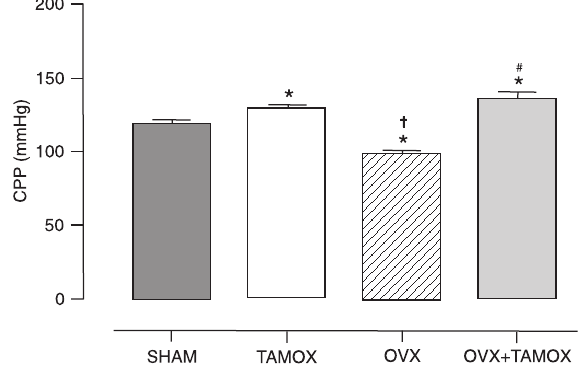
Figure 1. Coronary perfusion pressure (CPP) of isolated hearts obtained from spontaneously hypertensive female rats in the four treatment groups (SHAM, TAMOX, OVX, and OVX+TAMOX; for abbreviations, see legend to Table 1). Data are reported as means ± SEM (N = 7 animals in each group). *P < 0.05 compared to the SHAM group; # P < 0.01 compared to the OVX group; † P < 0.01 compared to the TAMOX group (ANOVA followed by the Tukey post hoc test).